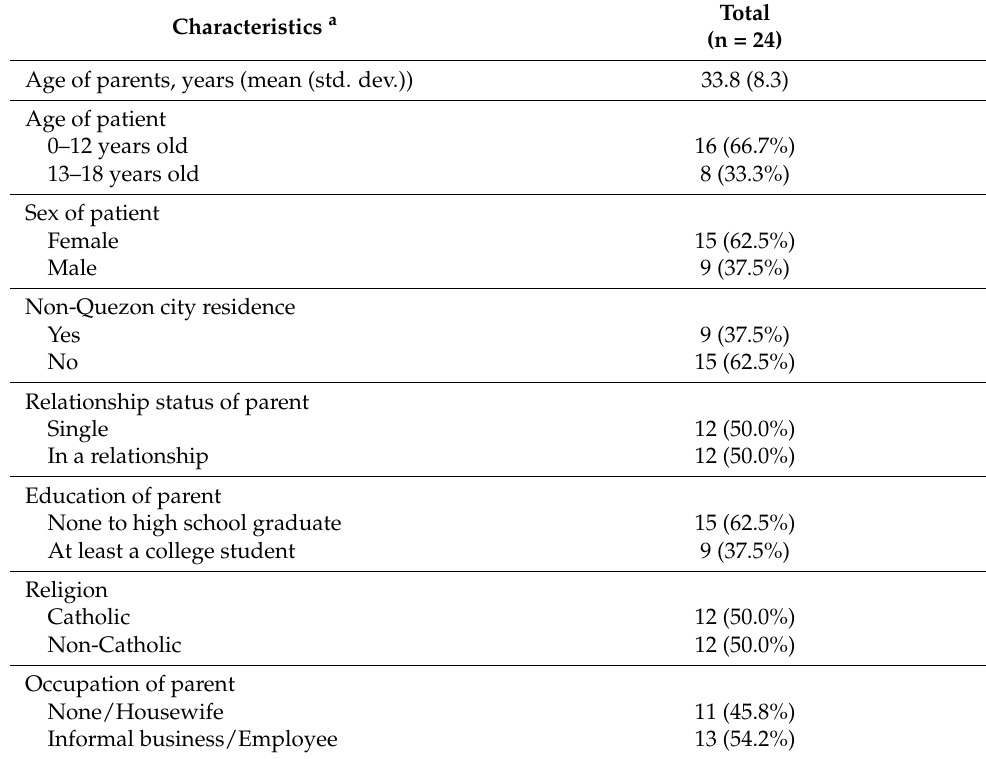
Figure 1. Three-Delay model for the qualitative assessment of delay to care among parents of the patients seeking treatment for dengue infection. Table 1. Study characteristics (n =